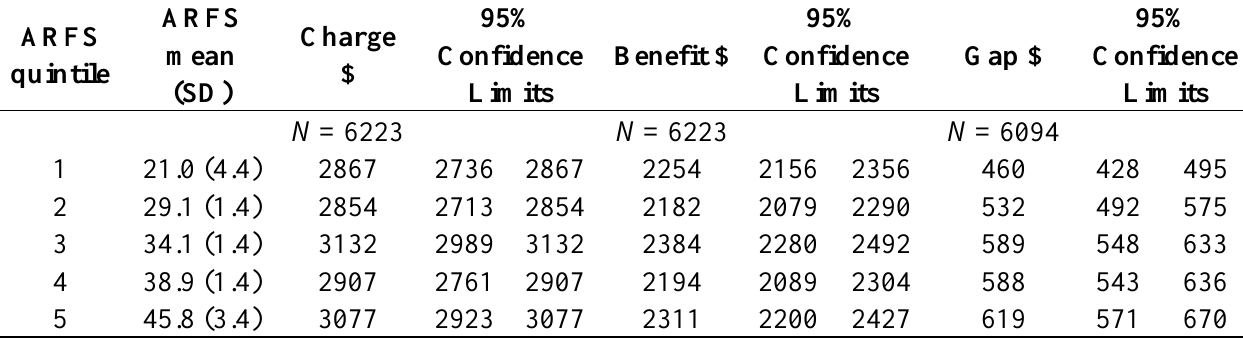
Table 1. Median five year (2002–2006) cumulative Medicare costs ($AUS) for mid-aged Australian women by quintile of ARFS, where 1 = lowest and 5 = highest